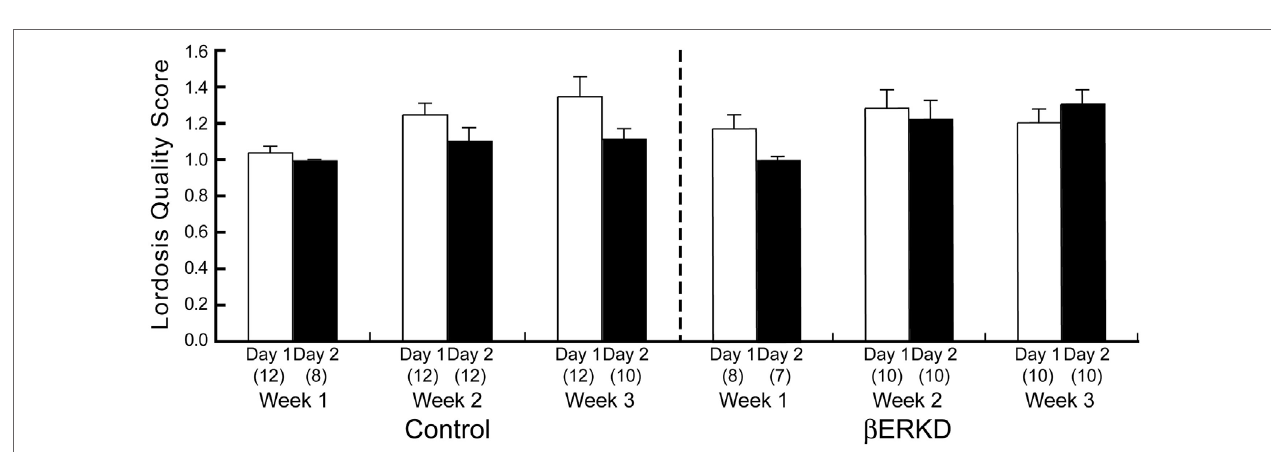
FigUre 5 | Effect of estrogen receptor (ER) β knockdown in the dorsal raphe nucleus on Lordosis quotient (LQ). LQ of control (left) and ER β knockdown ( β ERKD) (right) in each test. * P < 0.05 vs. day 1. Data presented as mean ± SEM.